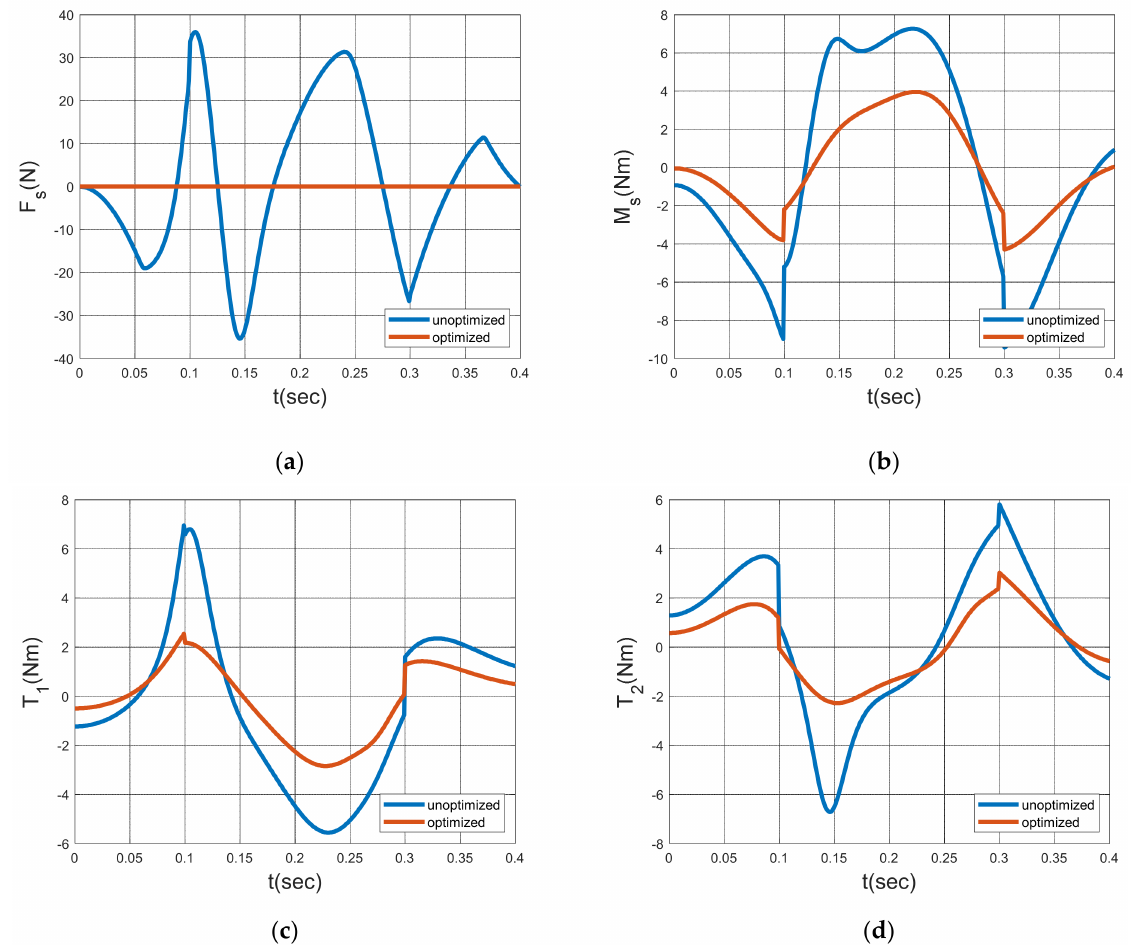
Figure 7. Results of optimization: shaking force ( a ), shaking moment ( b ), driving torque 1 ( c ), and driving torque 2 ( d ).